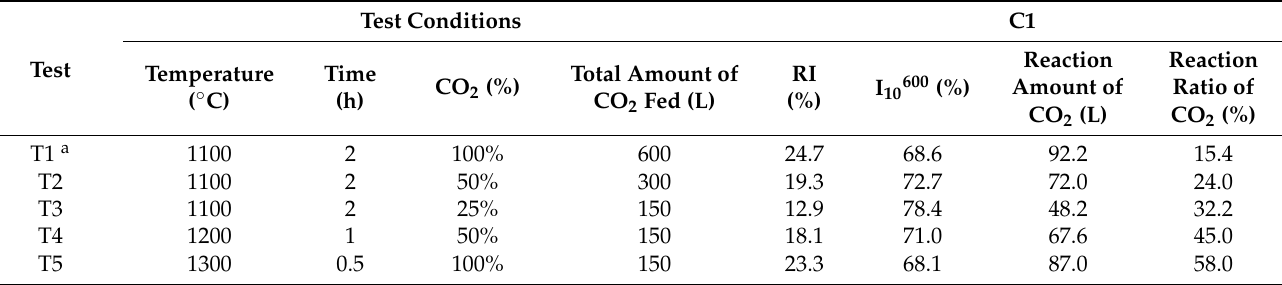
Table 2. Test conditions and RI/I 10600 results of metallurgical coke